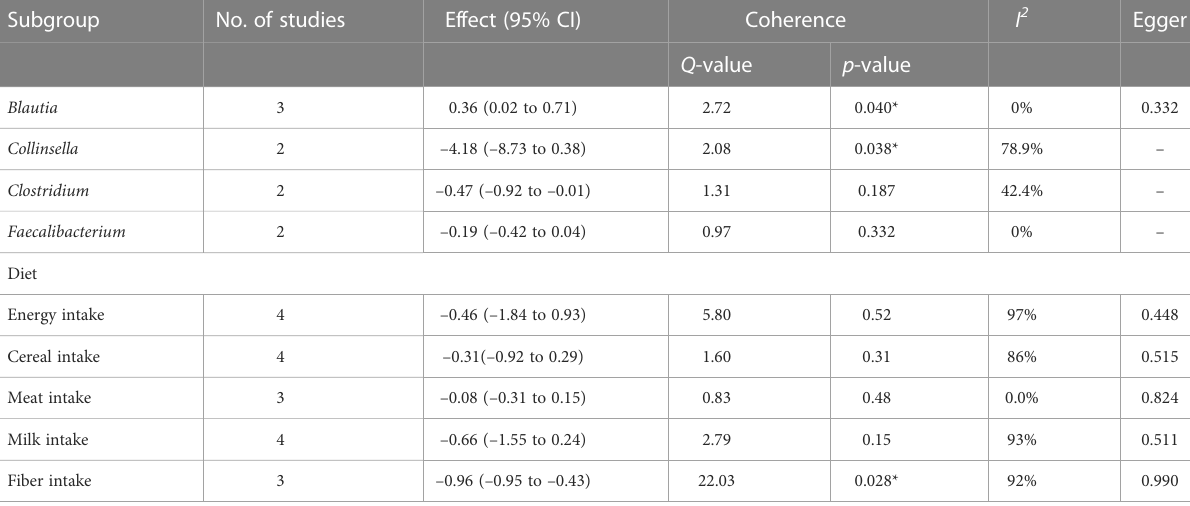
TABLE 1 Subgroup analysis of effect of gut microbiota and dietary intake.